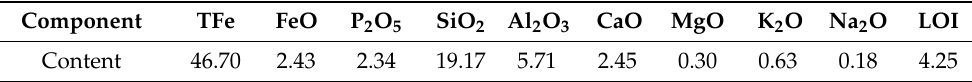
Table 1. The chemical composition of oolitic iron ore (mass